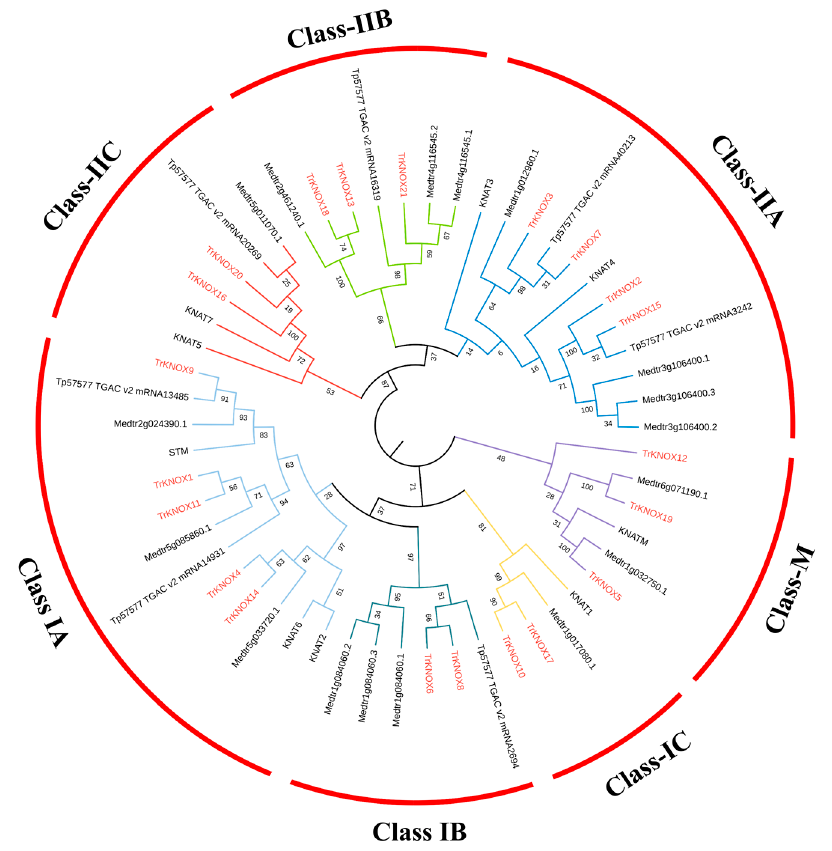
Figure 5. Phylogenetic relationships and motif compositions of KNOX family proteins of four related species. The tree divided the TrKNOX proteins into three subgroups, Class I, Class II, and Class